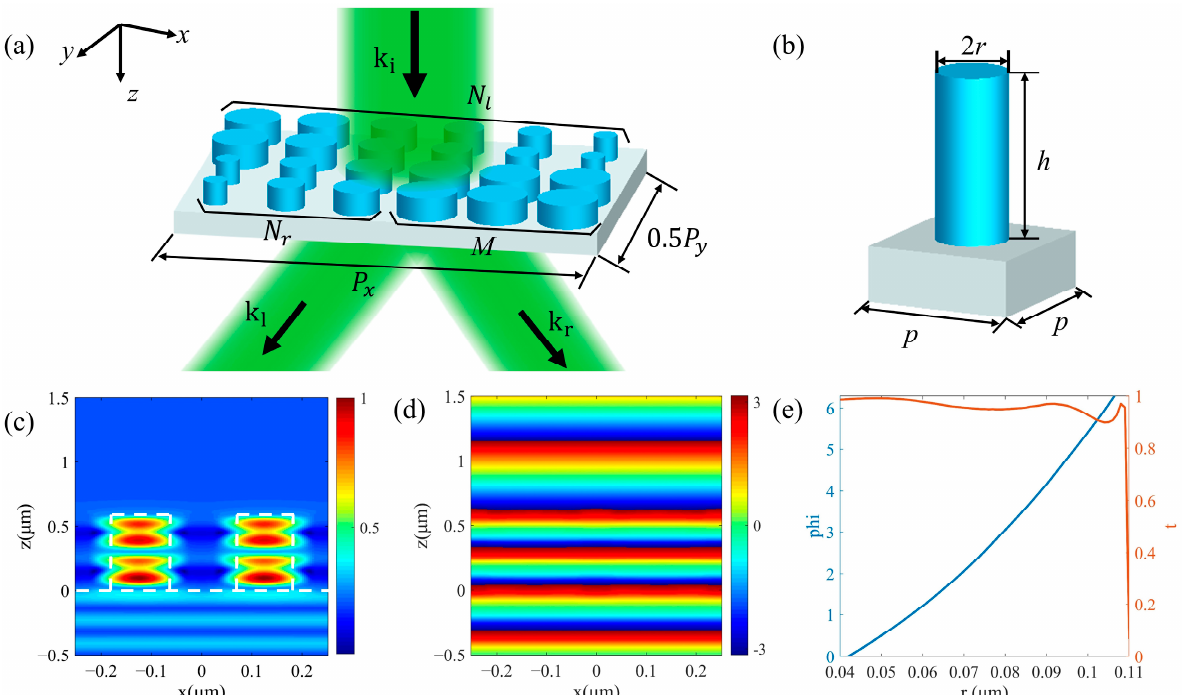
Figure 1. ( a ) Schematic of beam splitting by a super cell of beam splitter based on metasurface composed of nanorods. The beam is incident from the top through the metasurface and split into two beams in the x direction. ( b ) The 3D model of a single nanorod unit cell with radius r , height h , and period p . ( c ) The magnetic energy density distribution and ( d ) the progress of the phase change in the propagation of two nanorods with r = 100 nm, p = 250 nm by FDTD. The white dashed lines are the outline of the nanorods and the substrate. ( e ) The relationships between phase delay, transmission of the unit cell, and the radius of the nanorod.